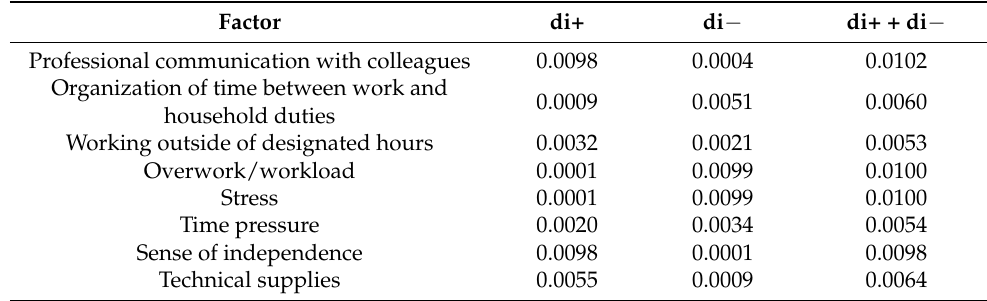
Table 9. Calculation of Euclidean distance.